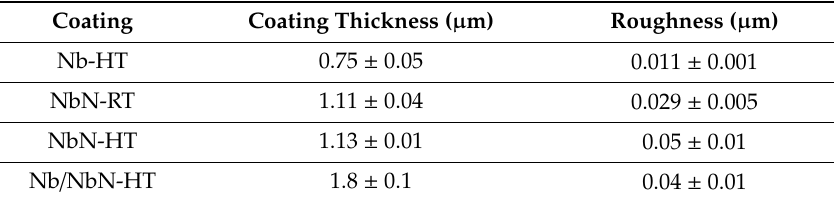
Table 3. Thickness and roughness of PVD-Nb-HT, PVD-NbN-RT, NBN-HT, and PVD-Nb / NbN-HT PVD coatings deposited on 304